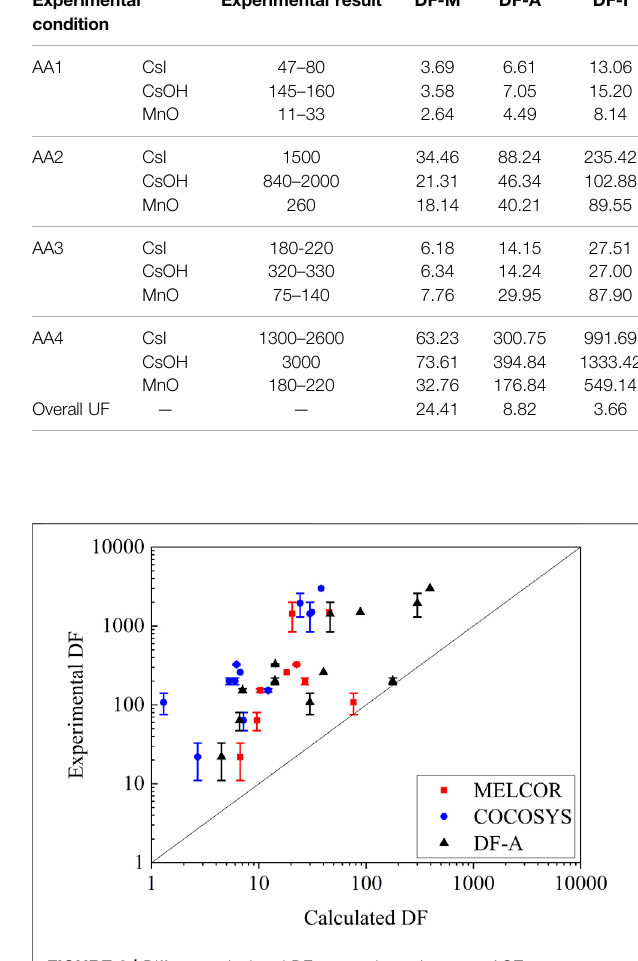
FIGURE 3 | Different calculated DF comparisons between ACE test